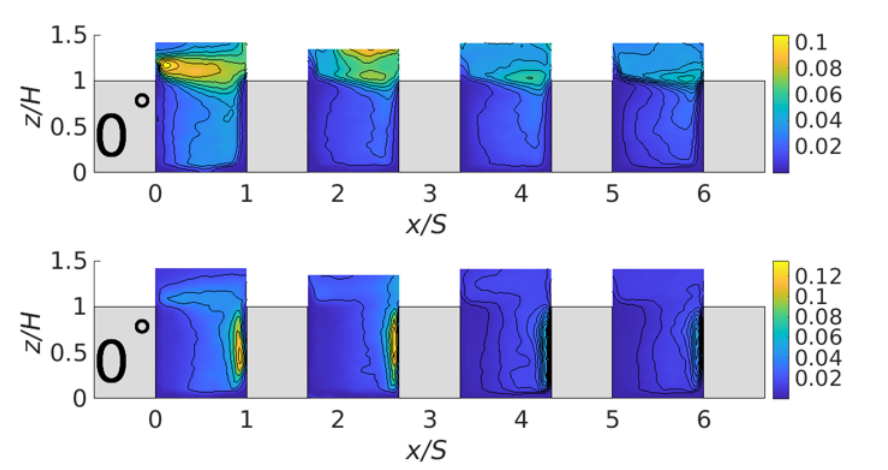
Figure 7. (Top) Square of the root-mean-squared velocity fluctuations (top) u 2 rms / U 2 v 2 rms / U 2 at y / W b = 0. Data extracted from the experiments by Monnier et al. [9]. Note that S H denotes street